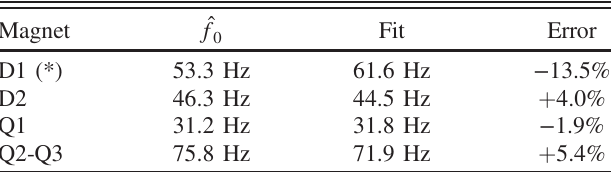
ˆ f TABLE IV. Estimation of 0 for the different cases studied and comparison with numerical fit of the simulated data (assuming single pole behavior). (*): the fit with robust options activated gives better estimations between 59.4 Hz and 59.6 Hz and hence an error not greater than 10.7%. For the sake of uniformity though the fitted cutoff frequencies reported here have been calculated with the same algorithm and settings.